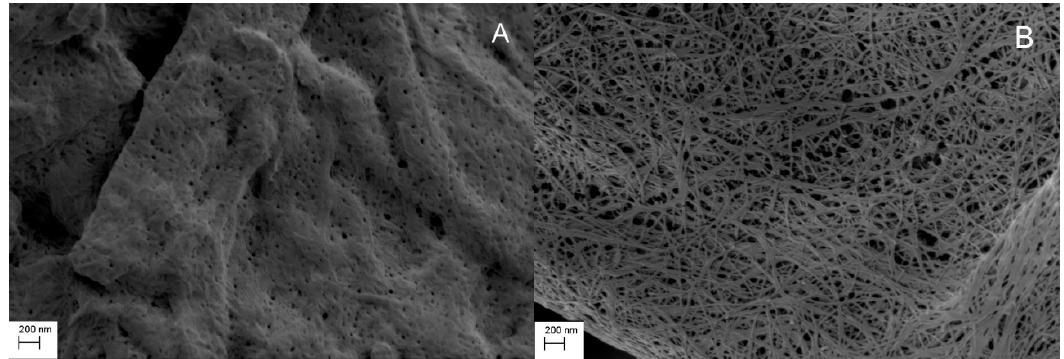
Figure 1. Scanning electron microscopy (SEM) image of ( A ) microcrystalline cellulose (MCC) and ( B ) Cladophora cellulose (CLAD). Magnification 20,000 ×